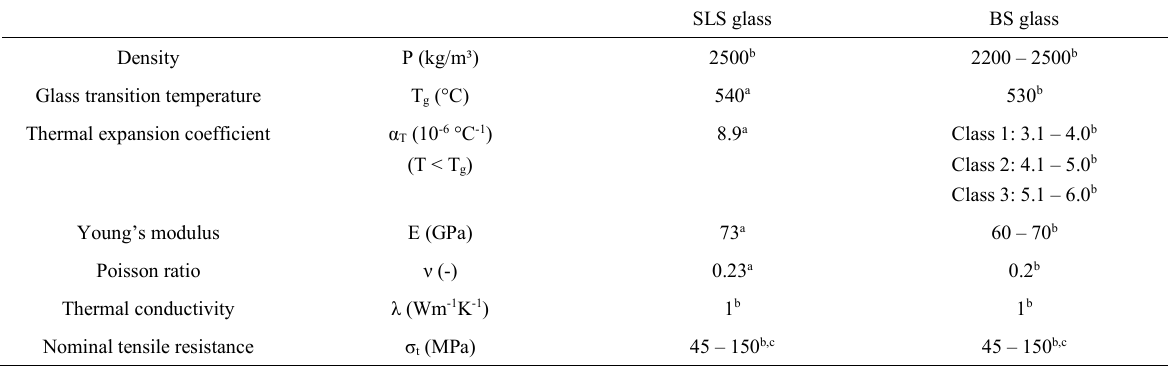
Table 1: Some thermal and mechanical characteristics of SLS and BS glass (Le Bourhis et al. 2003; Haldimann et al.